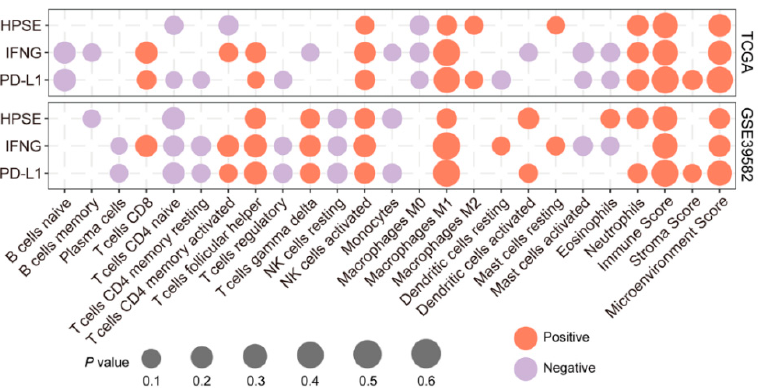
Figure 3. The heatmap of the correlations between gene expressions and immune cells infiltration in TCGA and GSE39582.